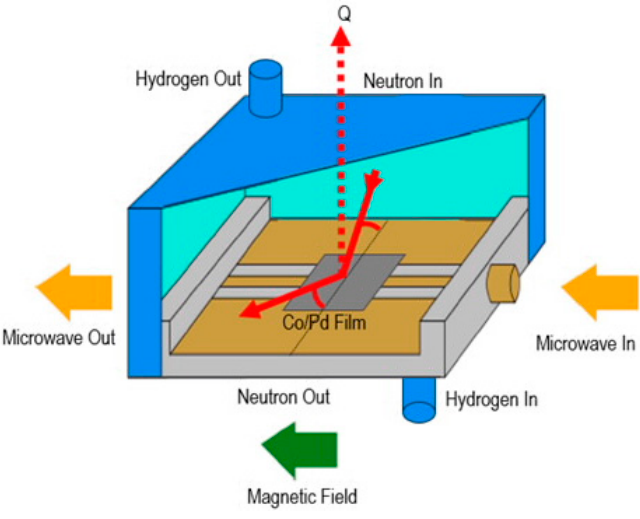
Figure 5. Schematic of the FMR/PNR experimental chamber.